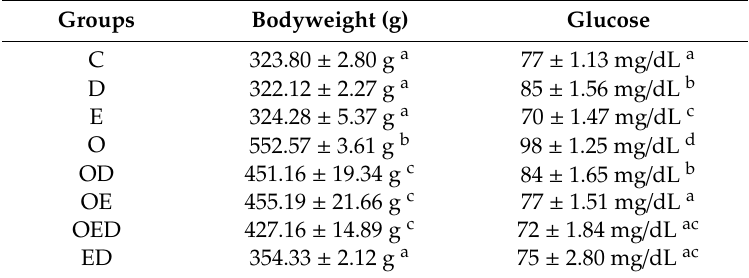
Table 3. Weight and glucose at the end of the treatments; C: control; D: diazoxide; E: exercise; O: obese; OD: obese diazoxide; OE: obese exercise; OED: obese exercise diazoxide; ED: exercise diazoxide. The data are represented as the mean ± standard error. Di ff erent letters indicate statistically significant di ff erences between groups ( p < 0.05) one-way ANOVA, Tukey post-hoc test, n =